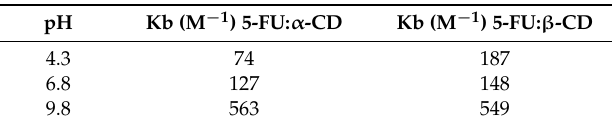
Figure 5. Dependence of 5-FU absorbance from β -CD concentration in aqueous solutions at different pH values: ( a ) pH = 4.3 ( λ = 266.2 nm); ( b ) pH = 6.8 ( λ = 266.4 nm); and ( c ) pH = 9.8 ( λ = 269.8 nm). Table 1. The binding constants of 5-FU: α CD and 5-FU: β CD evaluated by absorbance measurements at different pH values.